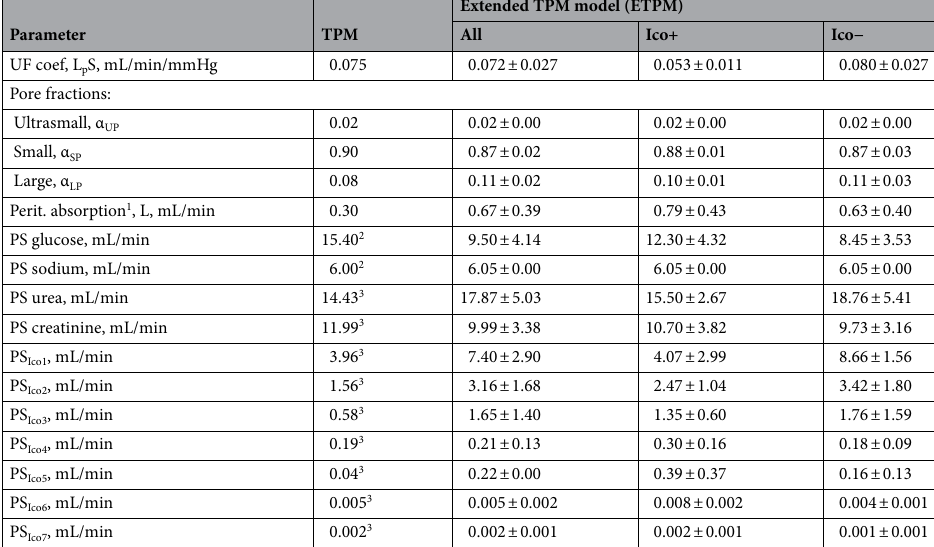
Table 1. The original (TPM) and extended (ETPM) three-pore model parameters estimated for individual data and expressed as mean ± standard deviation (SD) values calculated for all patients (All, n = 11) and for Ico+ (n = 3) and Ico− (n = 8) groups, where L P S denotes peritoneal ultrafiltration coefficient (hydraulic conductivity), α UP , α SP , α LP —fractional L P S accounted for by ultrasmall, small and large pores, respectively, L—peritoneal absorption, and PS —permeability-surface area product. 1 Peritoneal absorption calculated using volume marker absorption from the peritoneal cavity. 2 PS assumed in TPM and not derived from the